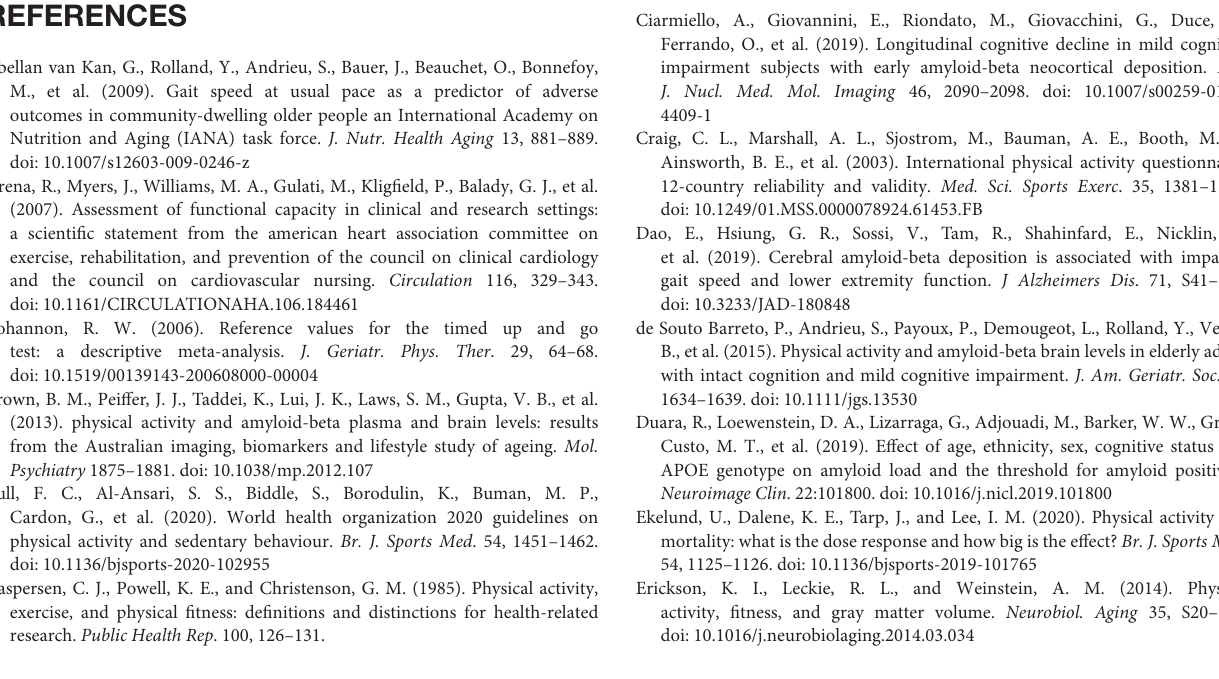
Supplementary Figure 1 | Flow chart of participants in the